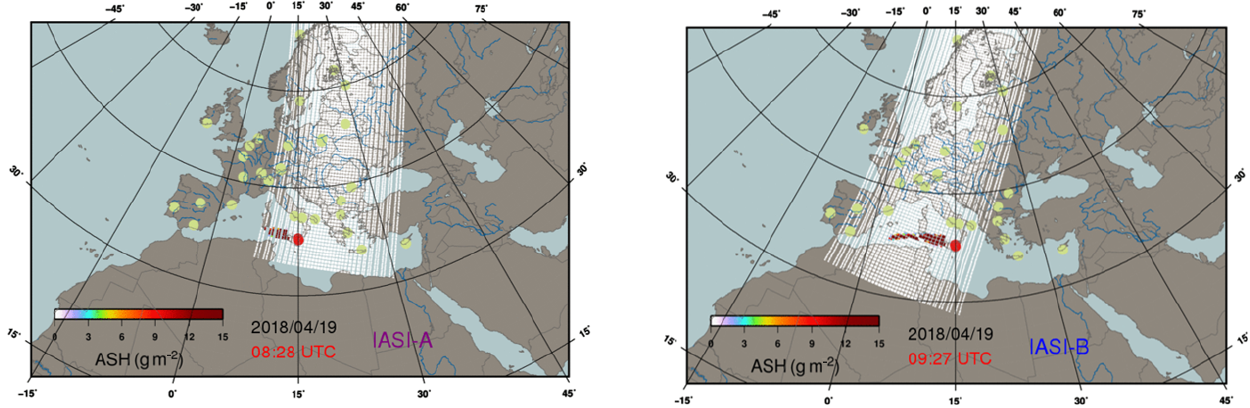
Figure 9. Warnings of ash plume by IASI-A (at 08:28UTC) and IASI-B (at 09:27UTC) on 19 April